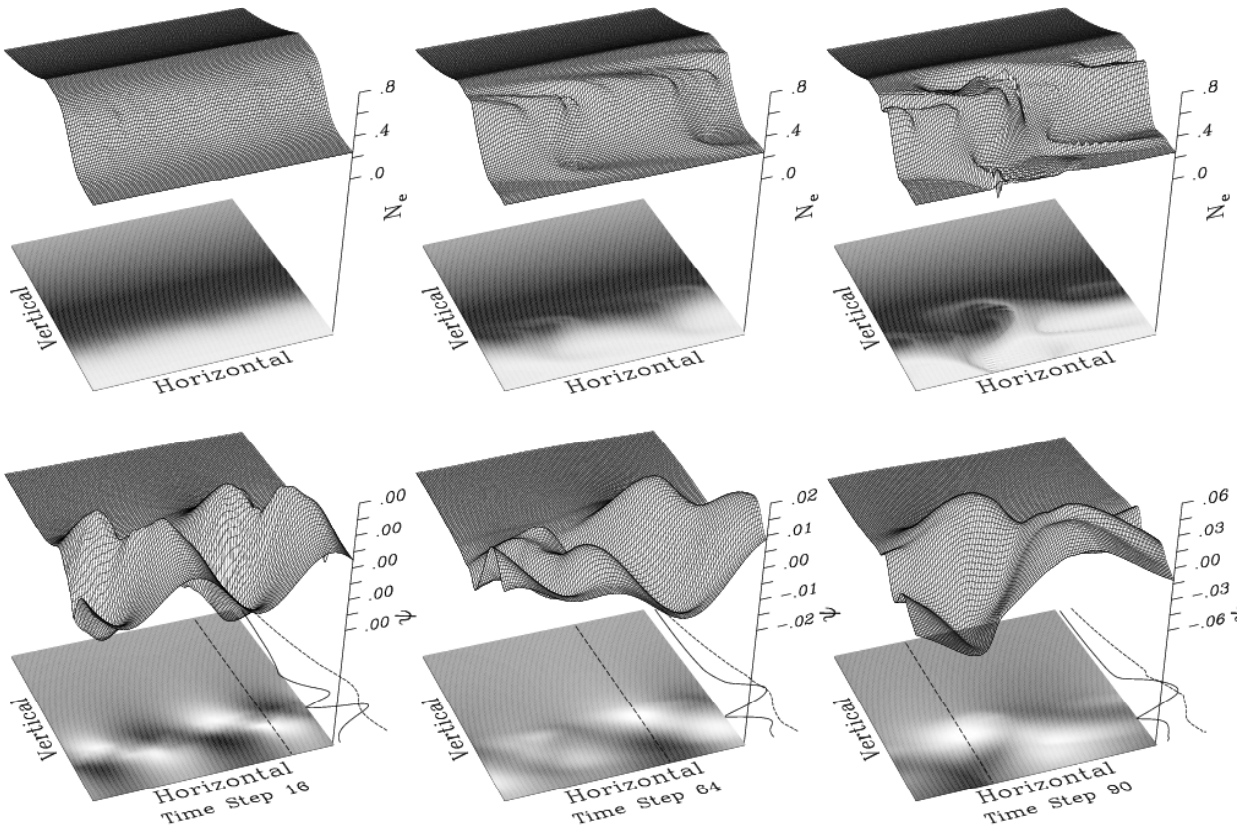
Fig. 19. Numerical simulation showing the development of a shear collisional instability in the bottom of the F-region. The model includes a sheared zonal plasma drift profile reversing to westward at lower altitudes, an altitude varying collision frequency and an eastward neutral wind. The top panel represents the plasma density, and the bottom, a stream function, which controls the drift velocity perturbations. Notice the 45° quasi-sinusoidal waves changing from a transient behavior to longer wavelength during the steady state. Transient and steady states have been identified before in linear analytical mathematical models involving shear flows (after Hysell and Kudeki, 2004).